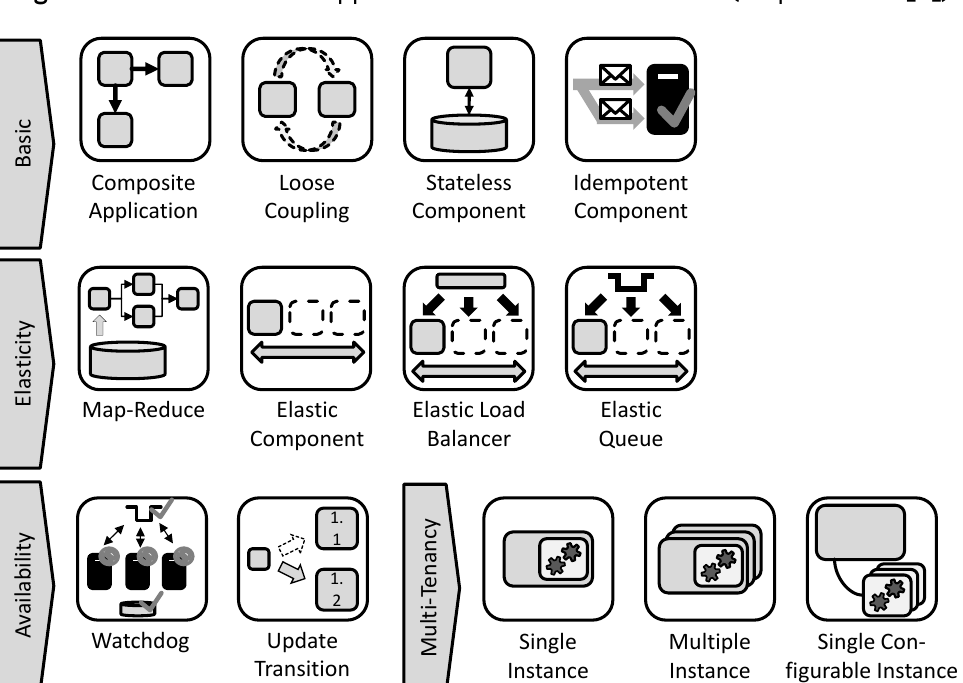
Figure 6. Icons of Cloud Application Architecture Patterns (adapted from